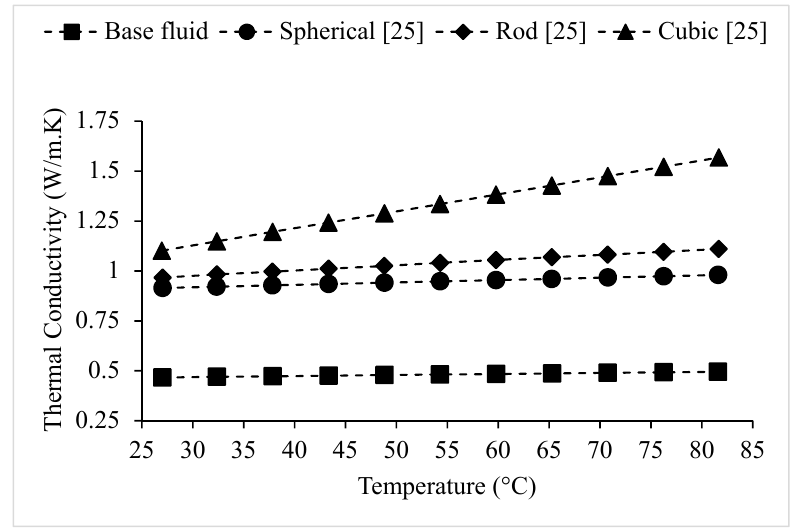
Figure 10. Effect of nanoparticle shape on the thermal conductivity of TiO 2 –water nanofluid at 𝜑 = 2.5%, as a function of temperature.